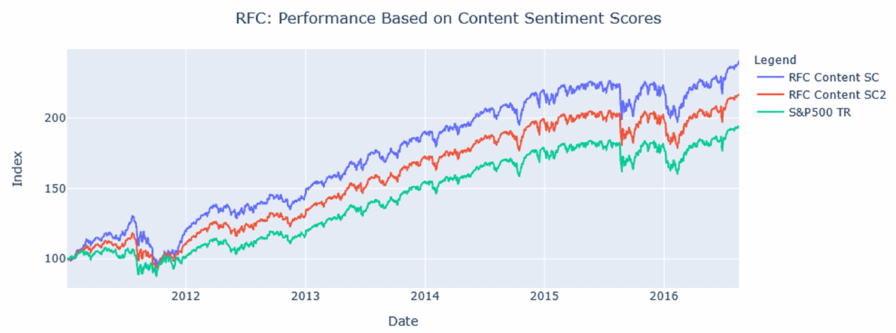
Figure 10. Out-of-sample performance random forest classification based on content sentiment